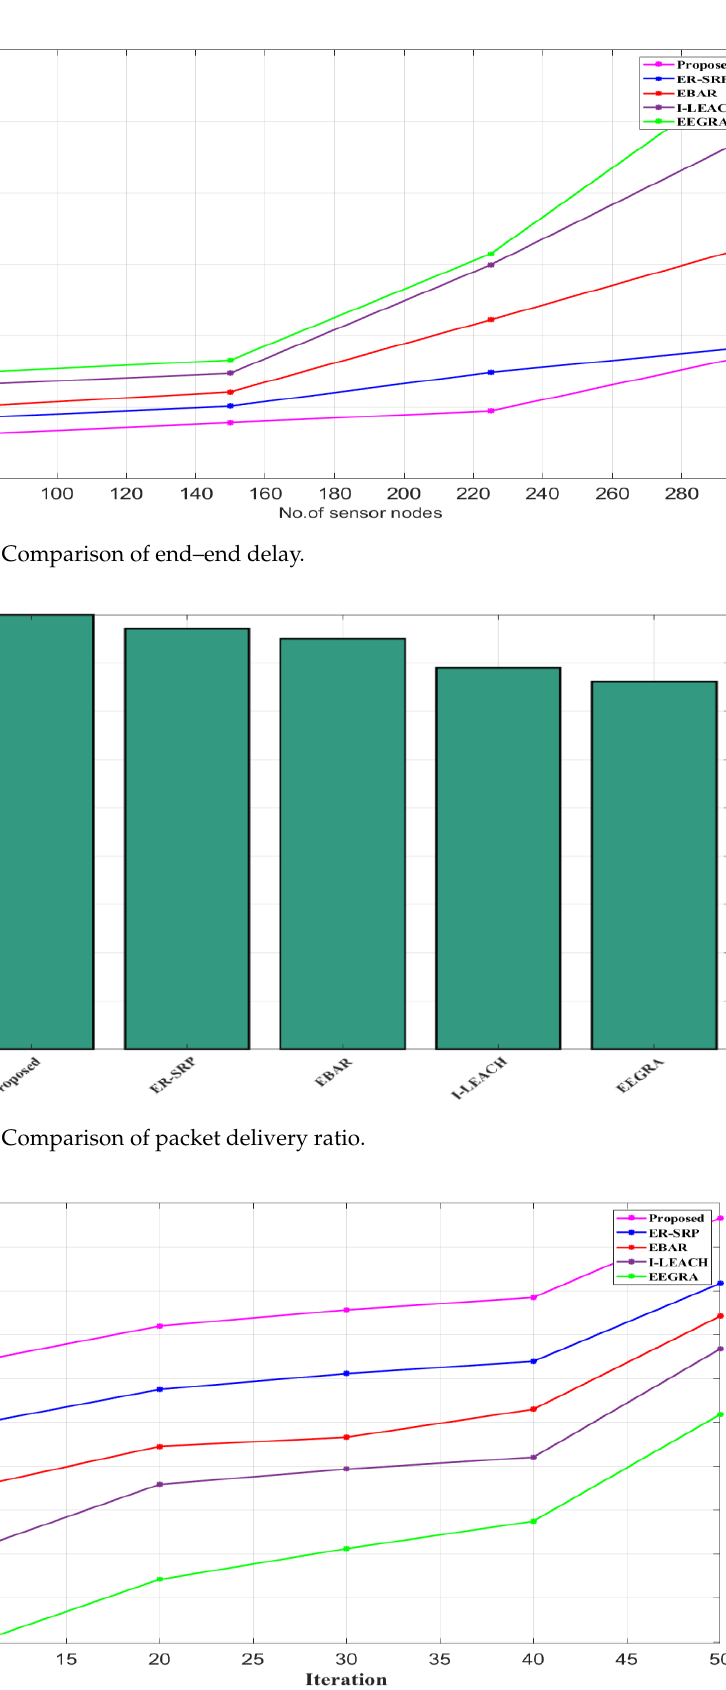
Figure 11. Comparison of packet delivery ratio.